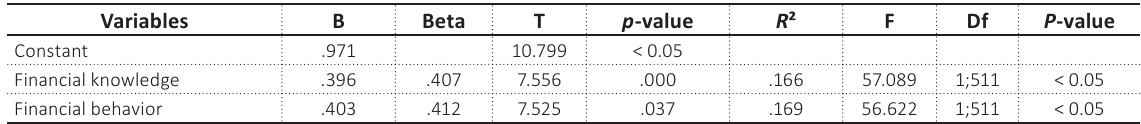
Table 2. Financial knowledge and financial behavior as predictors of business risk-taking